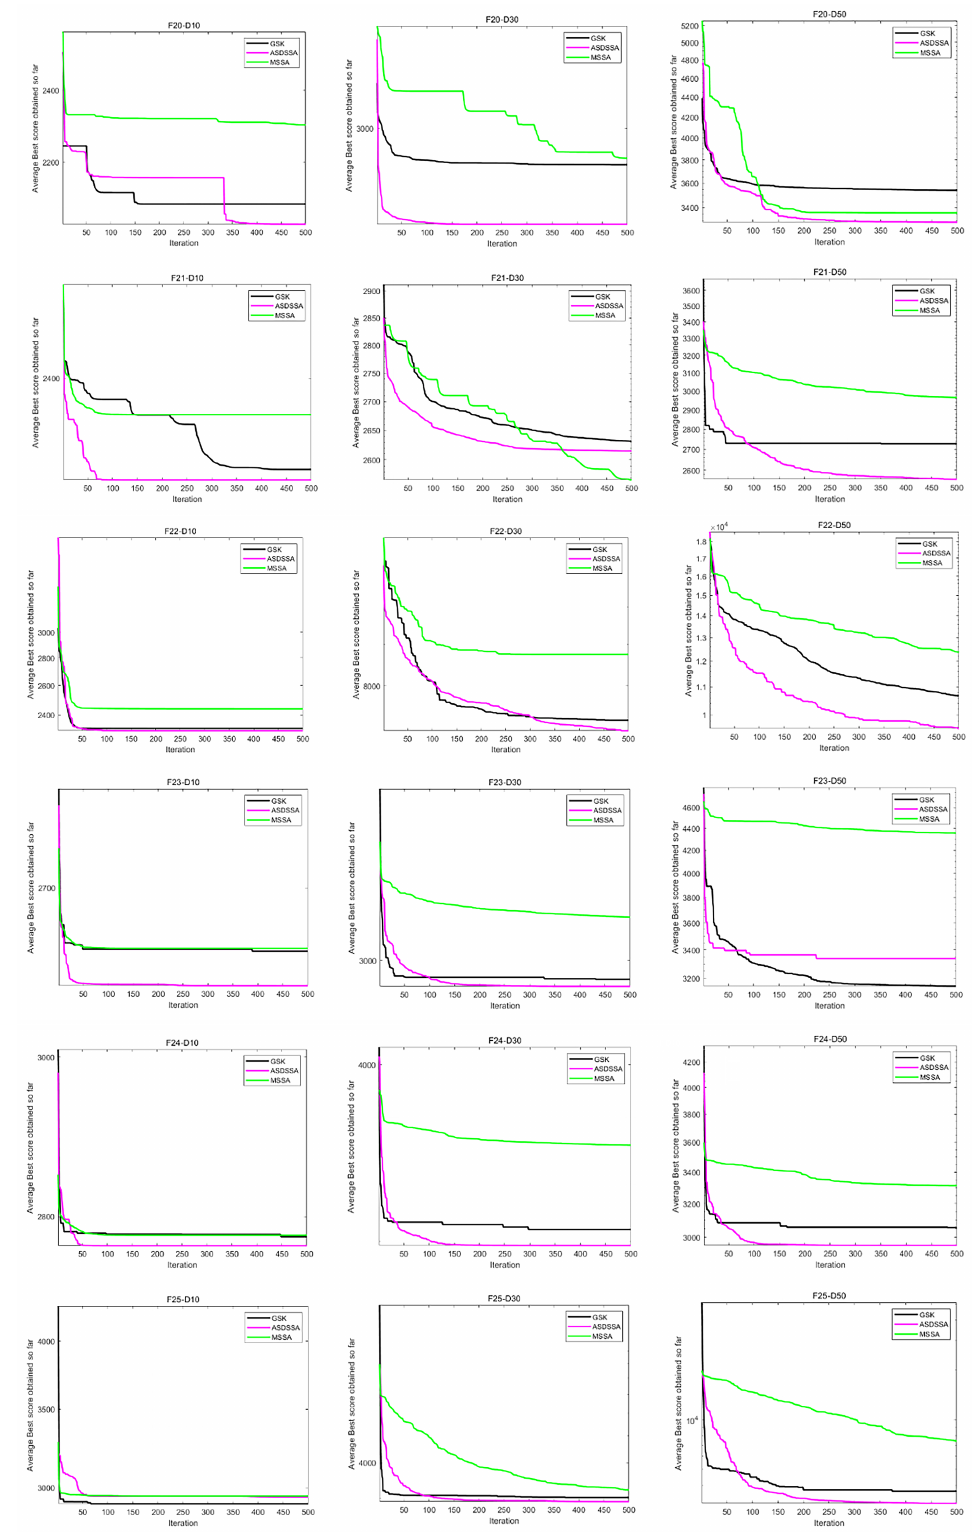
Figure 8. Convergence curves of